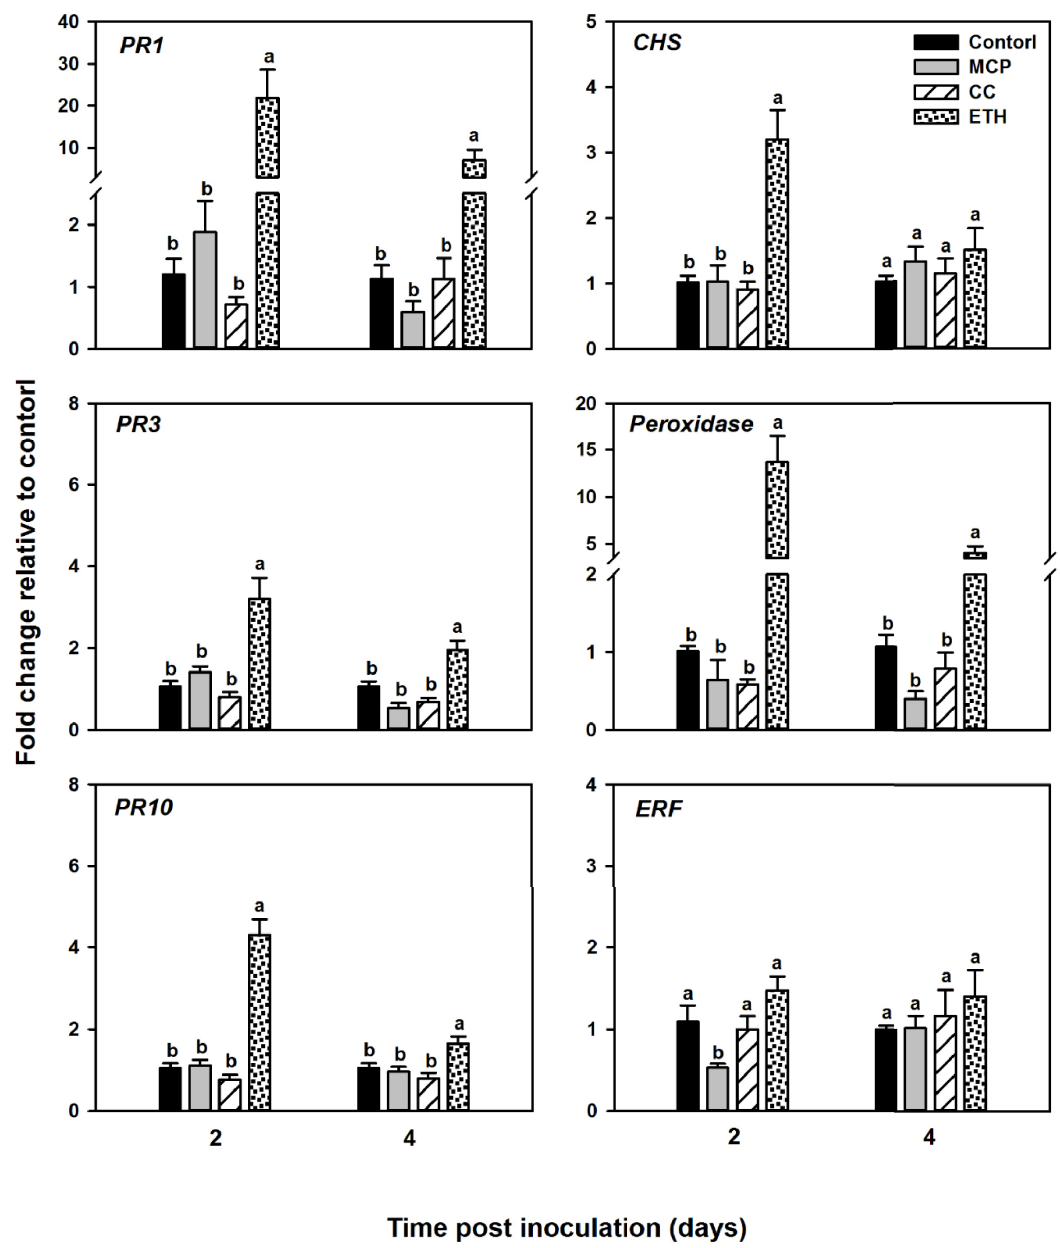
Fig 6. Effect of chemical treatments on the expression of soybean defense-related genes in the resistant cultivar MN1606 infected with Fusarium virguliforme . Soybean seedlings were drenched with water (control), ethephon 4 mM, cobalt chloride 1 mM, or foliar sprayed with 1-MCP twenty-four hours pre and post Fusarium virguliforme inoculation. Roots were sampled at 2 and 4 days after F . virguliforme (DAI). The level of expression of pathogenesis-related protein 1 ( PR1 ), Chitinase class I ( PR3 ), Intercellular pathogenesis- related protein 10 ( PR10 ), Chalcone synthase ( CHS ), basic peroxidase ( Peroxidase ), and ethylene response factor 1 ( ERF1 ), is shown relative to that of control plants. Each column represents the mean fold change of eight biological samples (four samples × two runs), and each sample consisted of a pool of two plants. Error bar indicates standard error of the mean (n = 8). Columns with different letters are significantly different ( P <